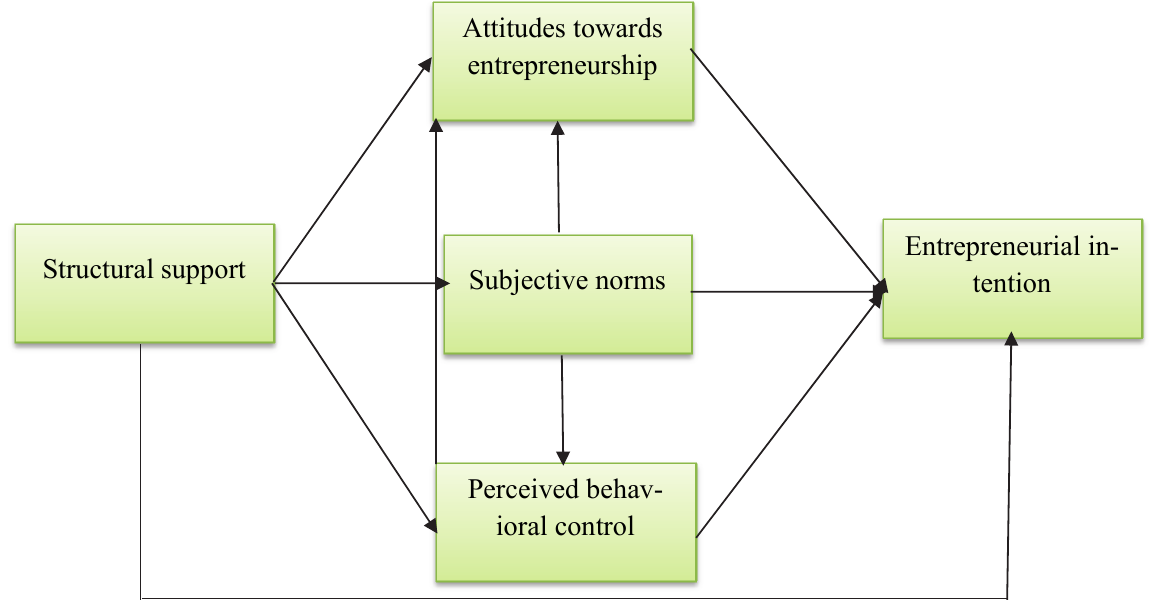
Fig.1. Conceptual